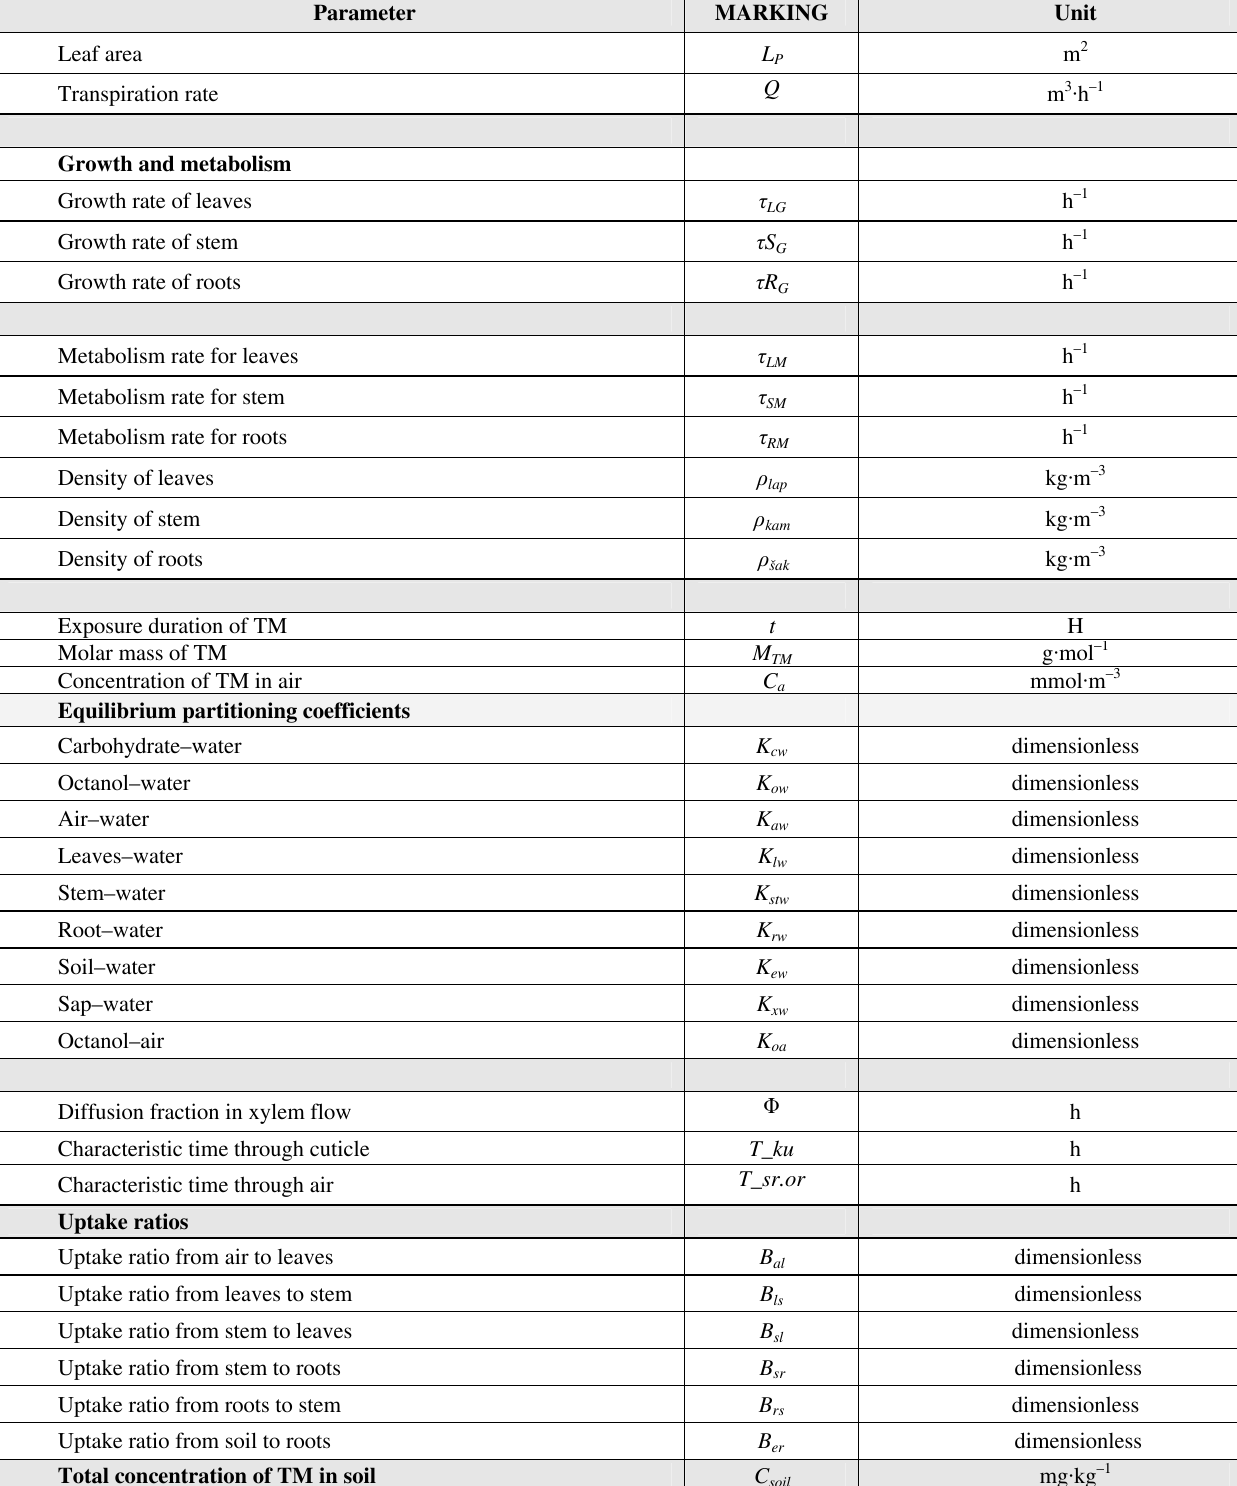
Table 1. Input and computed parameters to model TM uptake by a tree seedling Parameter